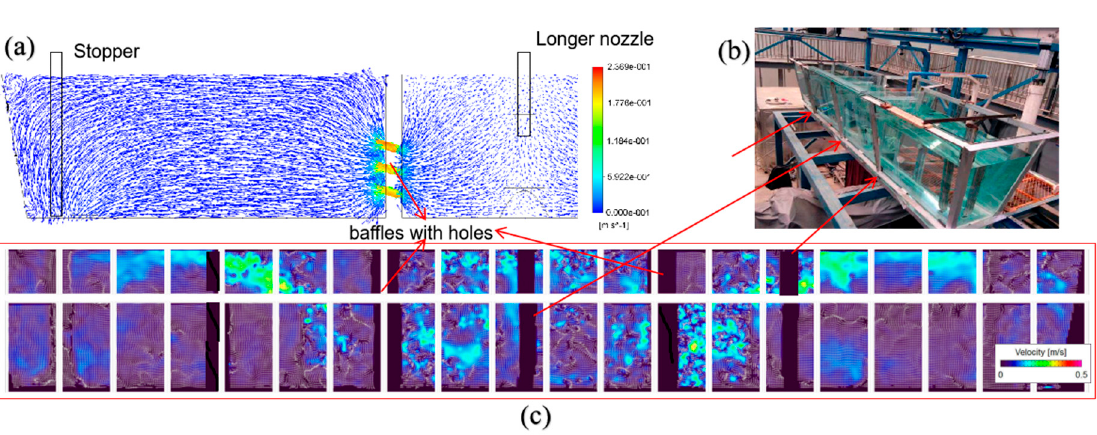
Figure 5. Flow measurement and simulation result of scheme A; ( a ) numerical simulation; ( b ) ( b ) experimental setup; ( c ) PIV experimental setup; ( c ) PIV measurements.